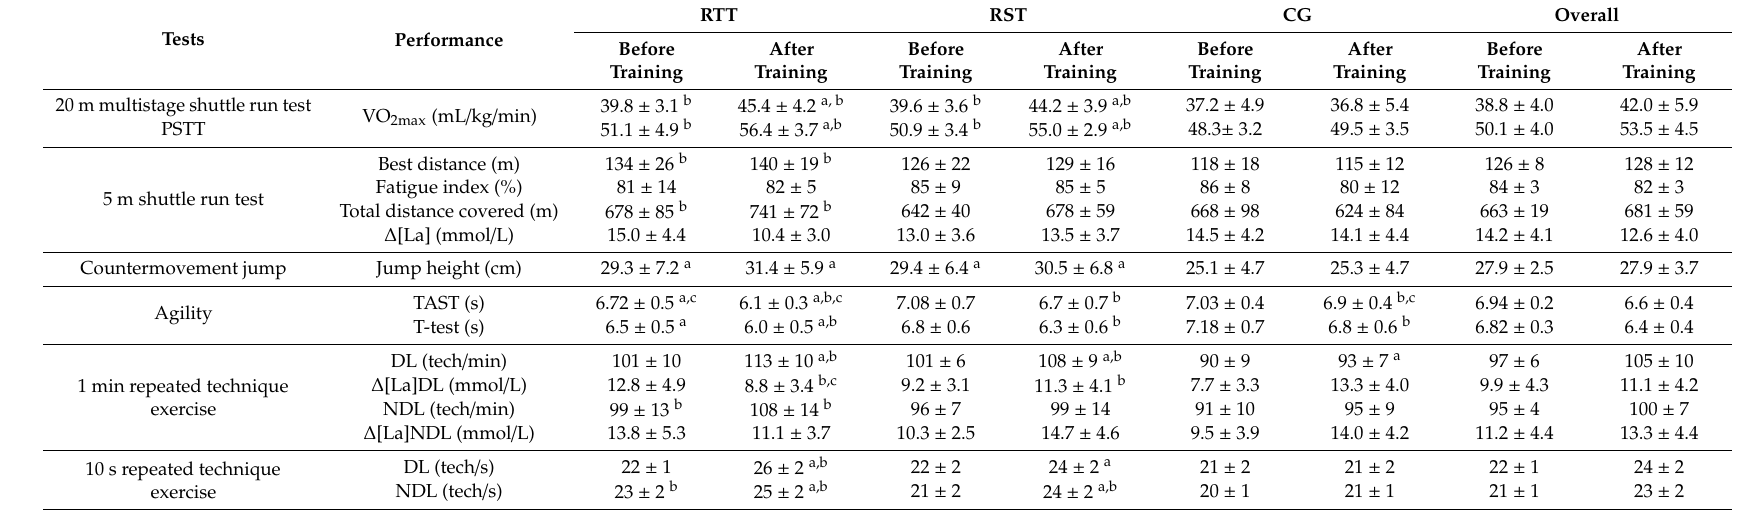
Table 3. Physiological and performance parameters before and after the training period (values are mean ± SD) for the repeated technique training group (RTT; n = 12), the repeated sprint training group (RST; n = 12) and the control group (CG; n = 12).